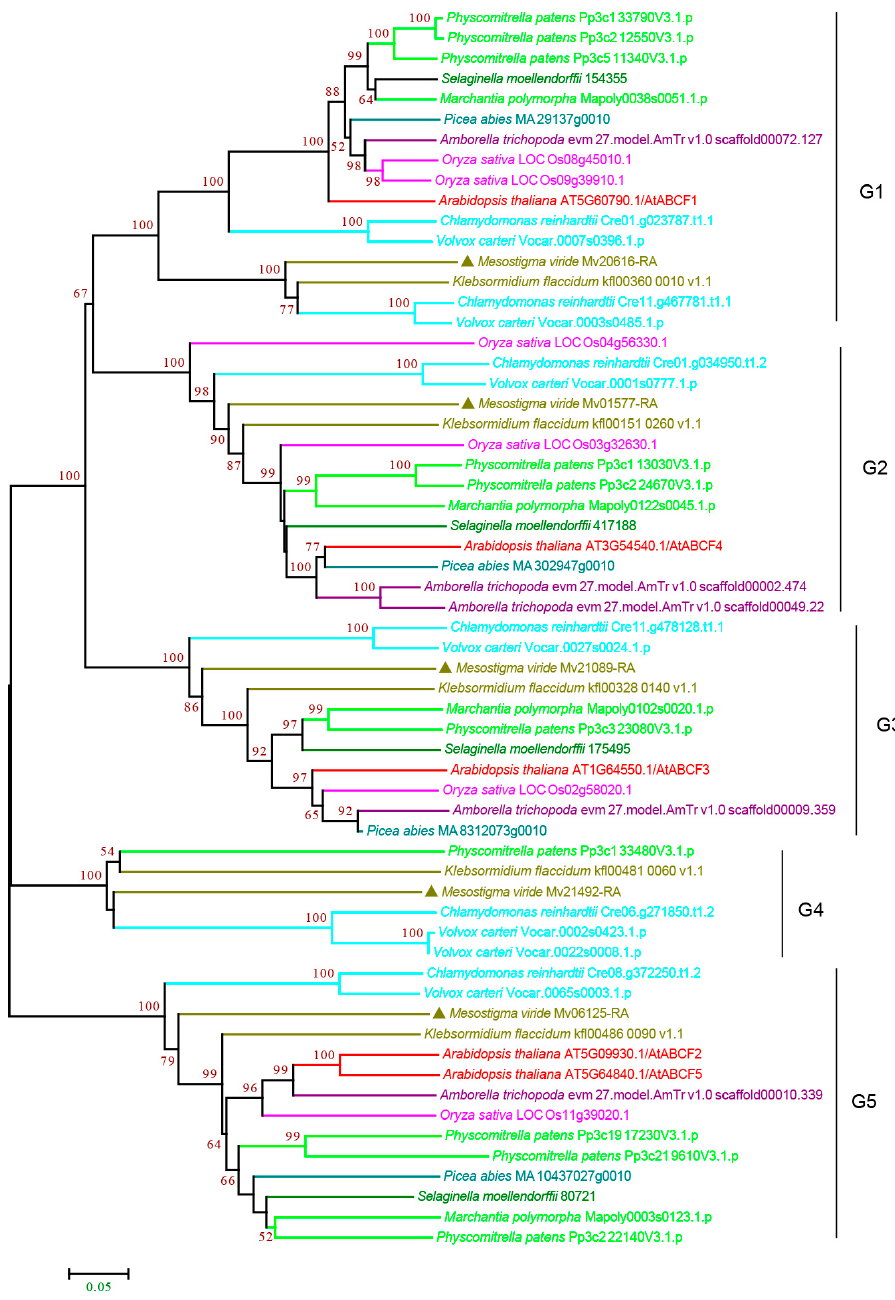
Figure 7. Phylogenetic analysis of ABCF subfamily proteins from 11 evolutionarily representative plant species. A neighbor-joining (NJ) tree was generated using MEGA7 with 1000 bootstrap repli- cates, and bootstrap values >50% are shown on the branches. The M. viride proteins are highlighted by triangles.